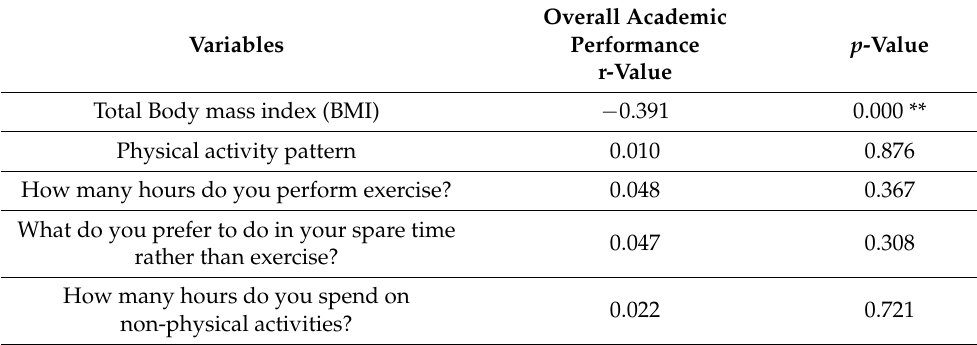
Table 4. Correlation among the overall academic performance level, total BMI and physical activity pattern of the studied subjects (n =